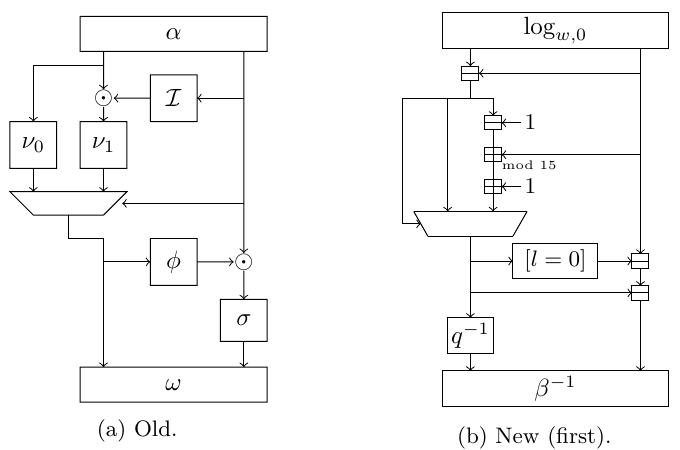
Figure 7: Old and new decomposition of 𝜋 . The multiplexers return the left side if the selector is equal to zero and the right side